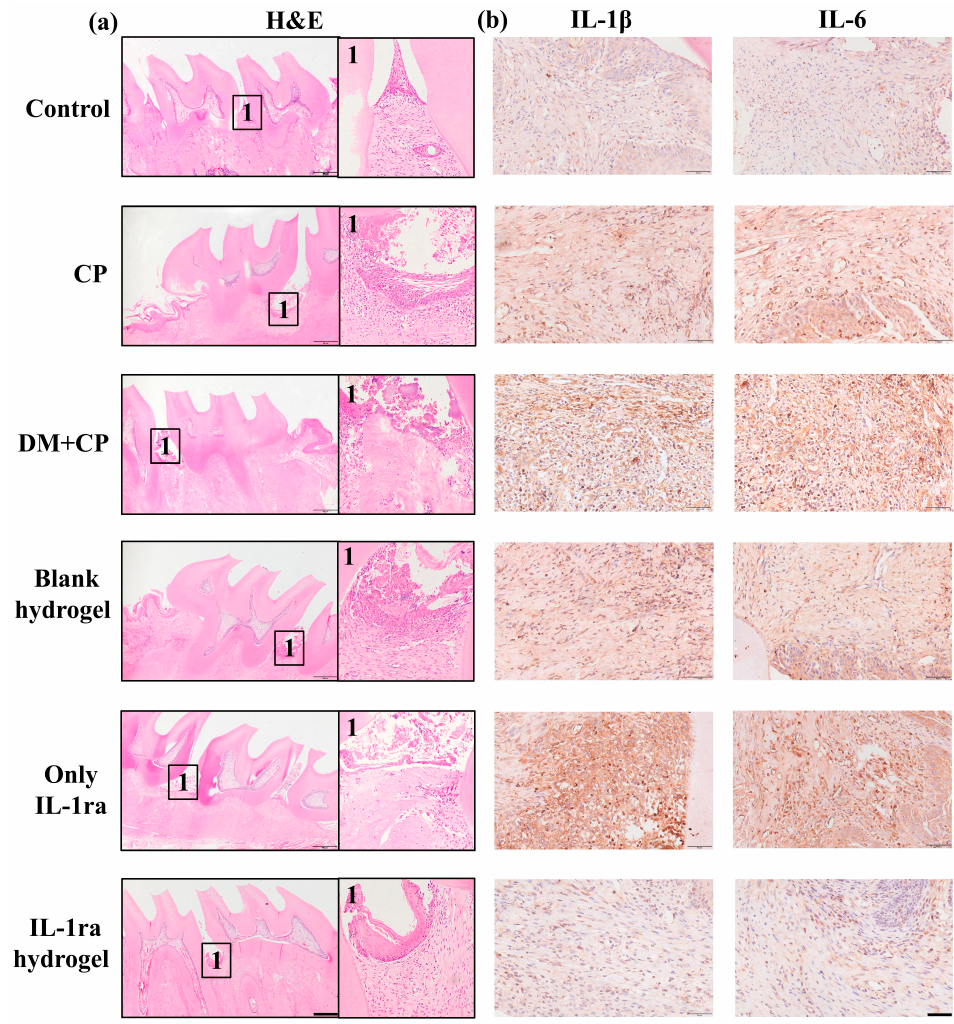
Figure 5. Immunohistochemical analysis of periodontal tissue sections in rats. ( a ) H&E image of the periodontal tissue section. The marked area is the periodontal tissue between the first molar and the second molar of rat maxilla, the part marked 1 in the figure shows more clearly and intuitively the expression of alveolar bone and gingival epithelium between the first molar and the second molar, scale bar represents 500 µ m. ( b ) The results of IHC staining of IL-1 β and IL-6 in periodontal tissues of rats in each group after 4 weeks of implantation, scale bar represents 50 µ